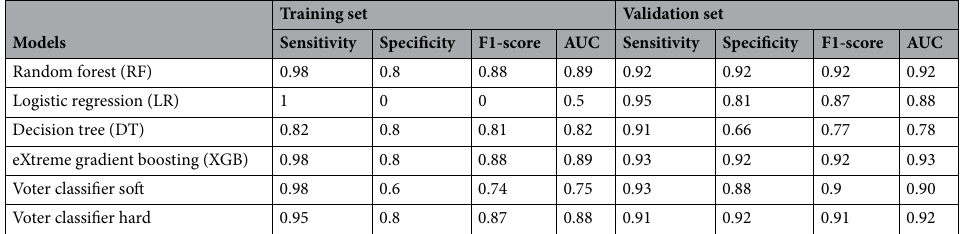
Table 4. Comparison between classification metrics of the different models in the training and validation